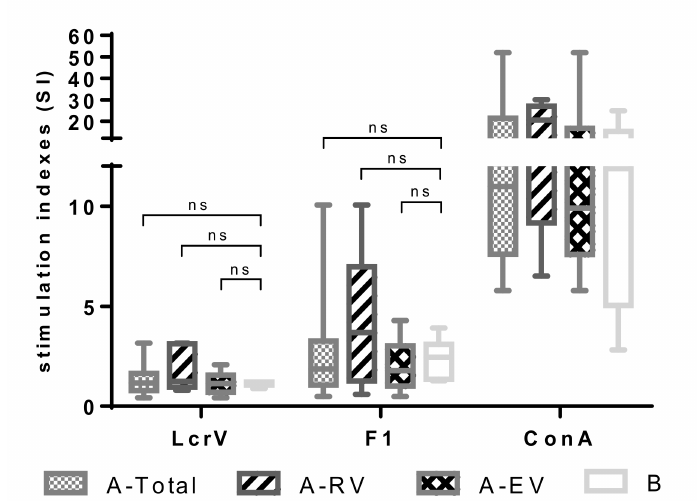
Figure 1. Proliferative response of peripheral blood mononuclear cells (PBMCs) obtained from vaccinated with live plague vaccine (LPV) (A-Total, A-recently vaccinated (RV), A-early vaccinated (EV)) and unvaccinated (group B) donors induced to in vitro F1 and LcrV stimuli. PBMCs